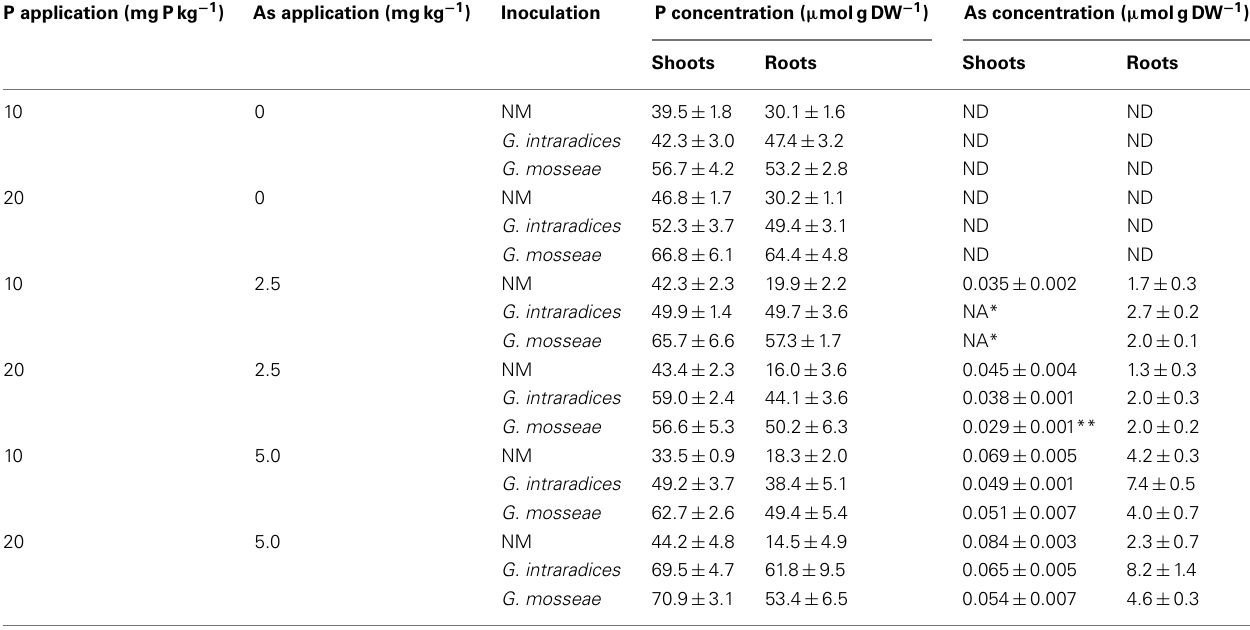
Table 4 | P andAsconcentrations ( μ molgDW − 1 ) in shoots and roots of medic ( Medicago truncatula) grown at two different P supplies (10 and 20mgPkg − 1 soil) and threeAs supplies (0, 2.5, and 5.0mgAskg − 1